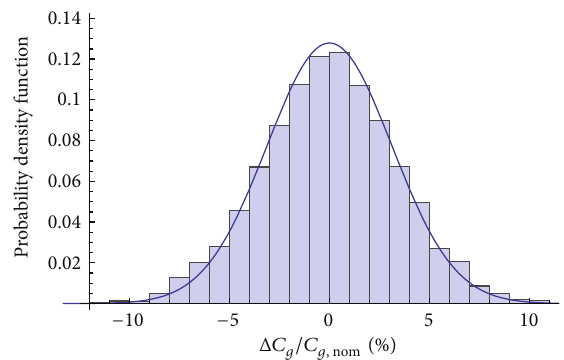
Figure 5: PMOS-based graphical comparison for the probability distribution of Δ𝐶 𝑔 : pdf Δ𝐶 tion from the circuit (histogram).